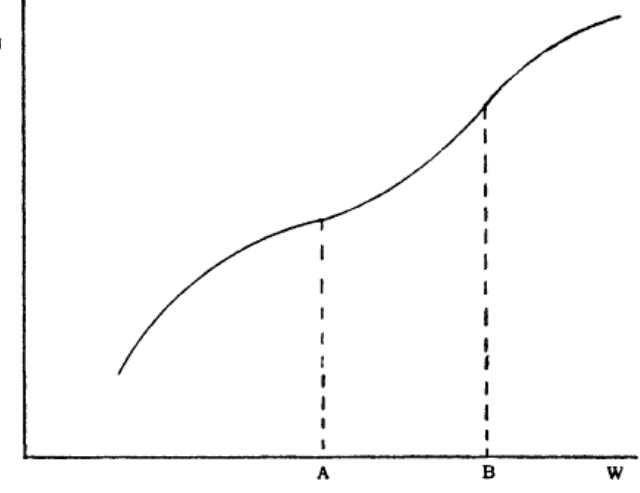
Figure 4. Friedman and Savage Illustration of the S-shaped utility curve